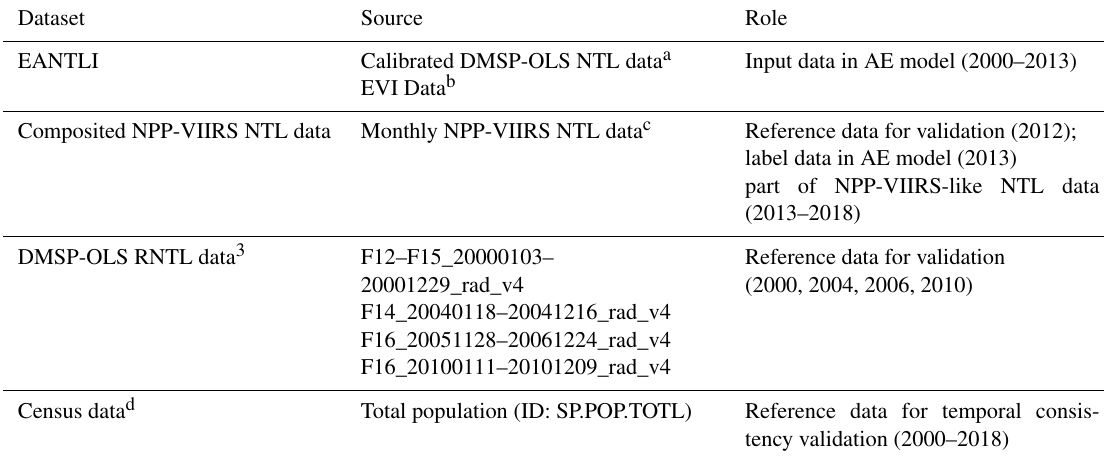
Table 1. The list of data used in this